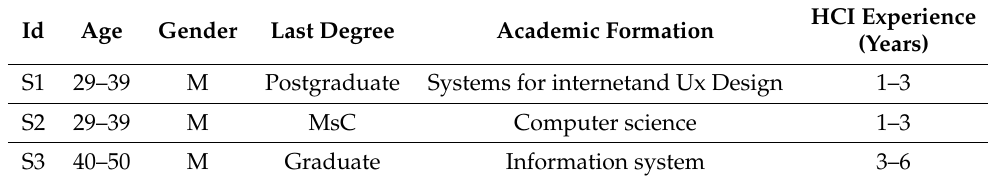
Table 1. HCI specialists